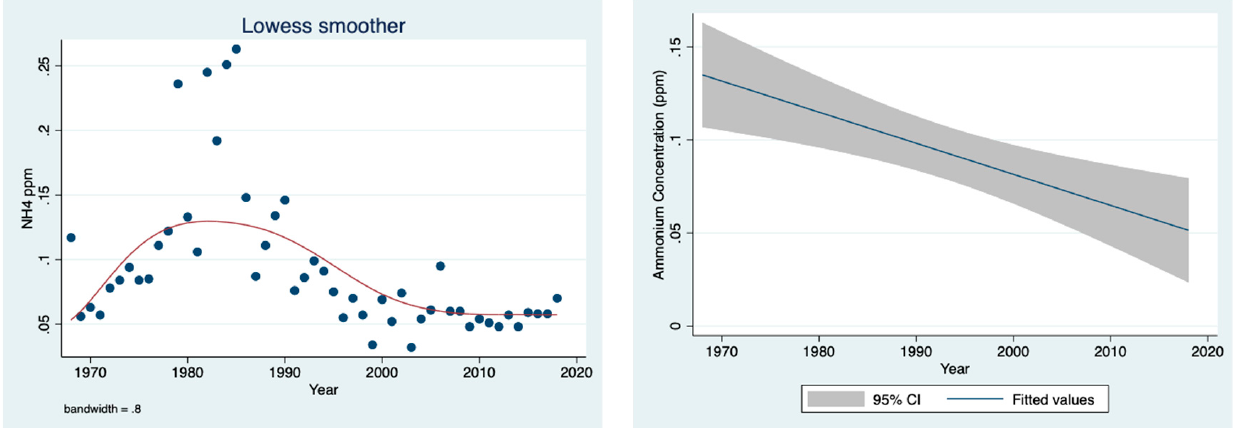
Figure 4. Linear prediction (95% CI) ( left ) and LOWESS smoother (0.8 bandwidth) trend of changes ( right ) between annual mean concentration (ppm) of ammonium in River Jordan waters and years (1968–2018).